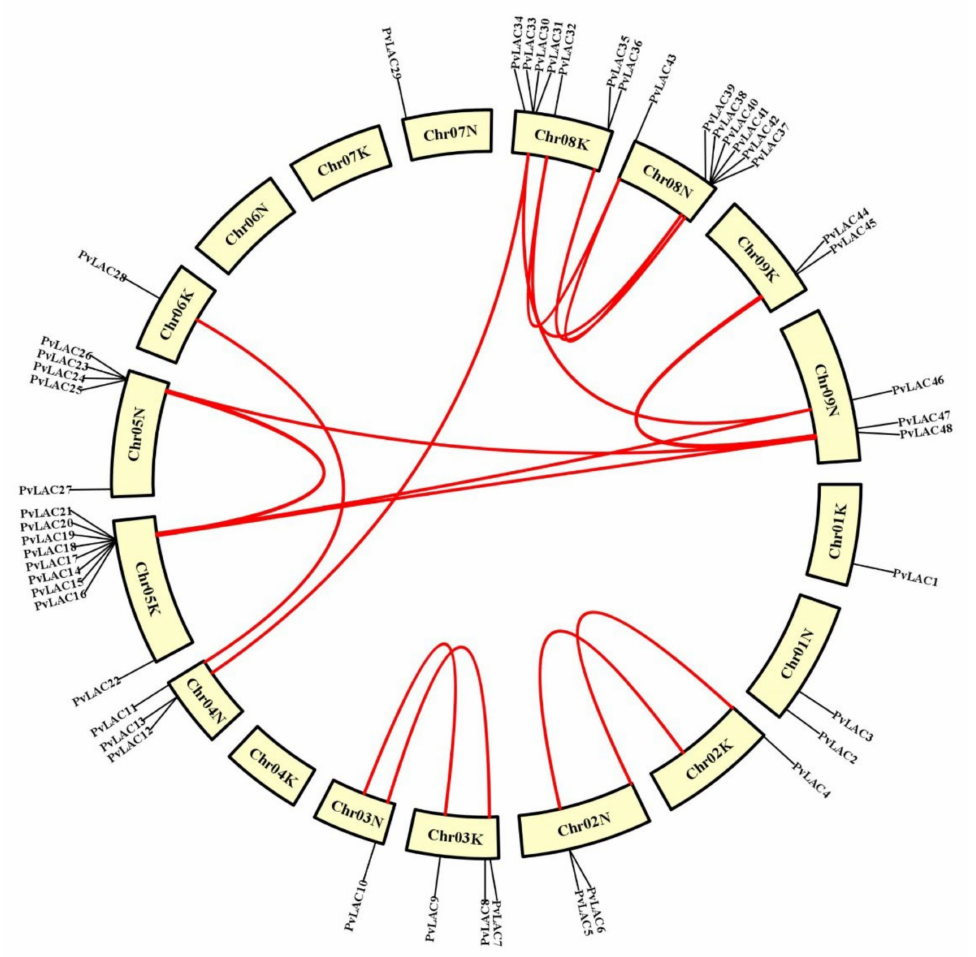
Figure 3. Colinear analysis of PvLac gene family. Red lines indicate duplicated PvLac gene pairs. The red line represented collinearity relationship between PvLac genes. Gene names are listed outside the circle, according to their chromosomal